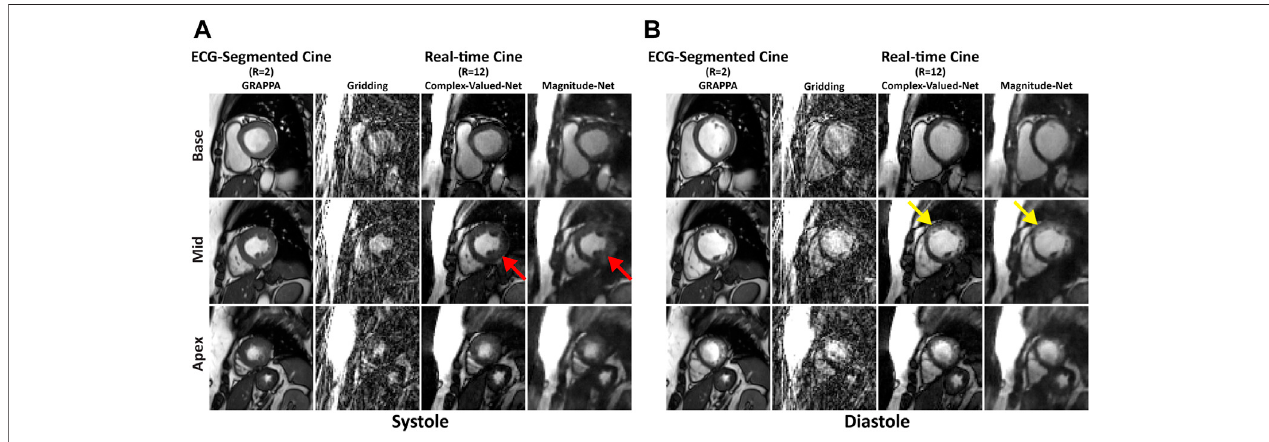
FIGURE2| Imagesatend-systolic (A) andend-diastolic (B) phasesforthreeshort-axisslices(base,mid,apex)inonepatient.Magnitude-Netexhibitsmoreimage artifact (red arrow) and greater blurring (yellow arrow) at the myocardial wall than Complex-Valued-Net. Gridding reconstruction produces non-diagnostic image quality.